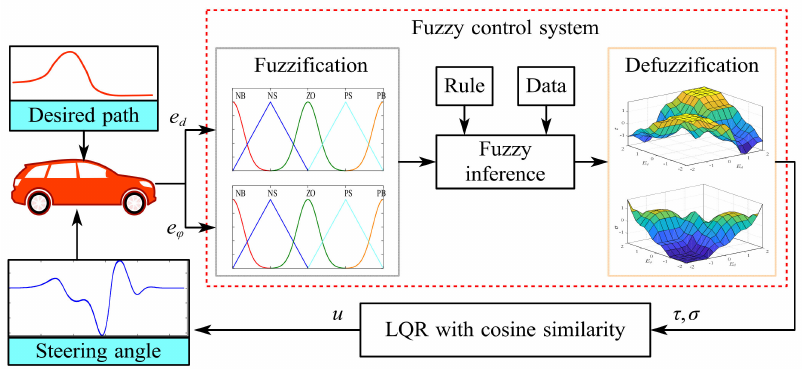
Figure 14. The structure of the fuzzy control system.